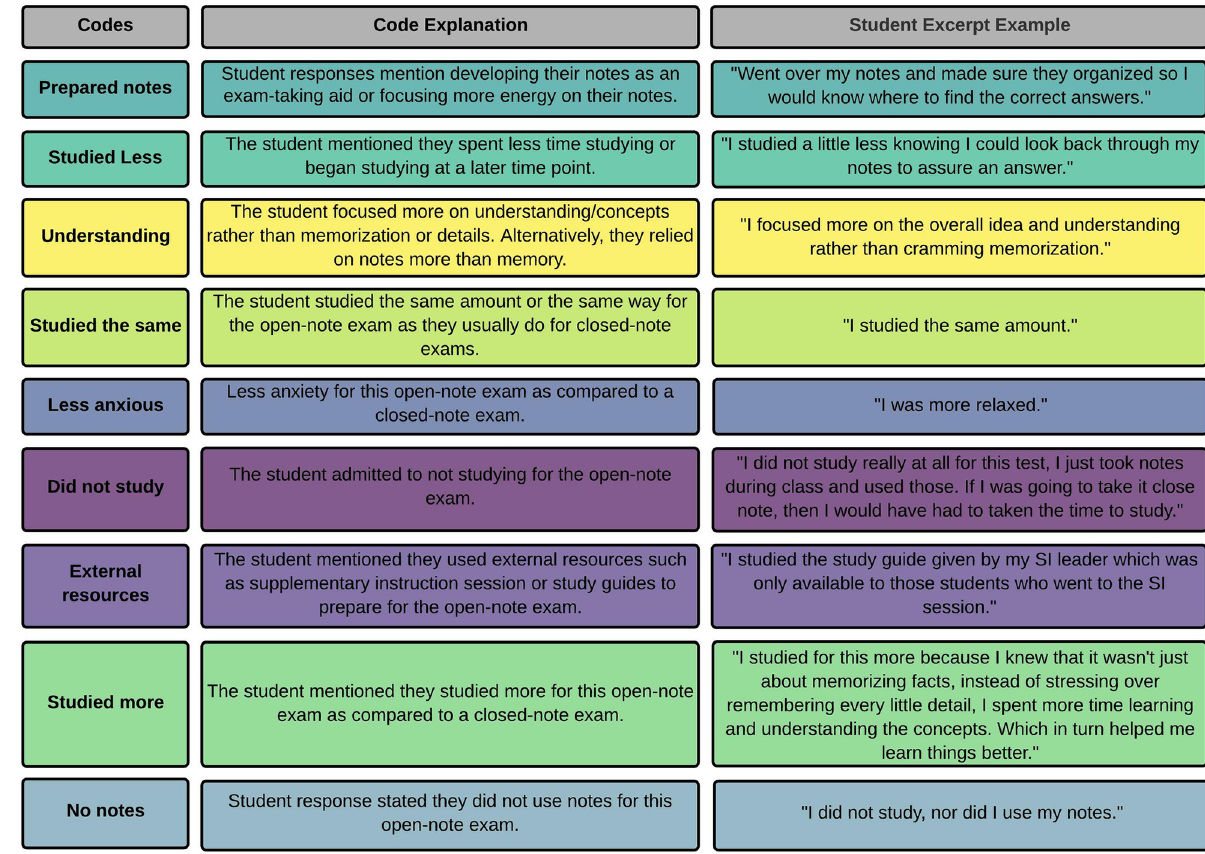
Fig 1. Emergent codes in student open responses to the open-ended question “ How do you think you studied differently for this open-note exam compared to how you would study for a closed-note exam ? ”